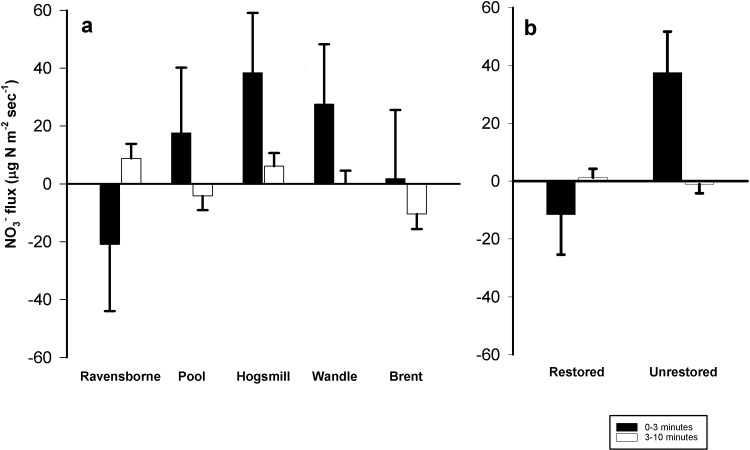
Average NO3- fluxes (μg N m-2 sec-1) among a) the study rivers (restored and unrestored combined) and between (b) the combined restored and unrestored reaches from all London rivers. Columns represent average values (N = 12–20) + one standard error. Both physical disturbance (T = 0–3 minutes) and biogeochemical activity (T = 3–10 minutes) are presented in each panel. There was no significant difference in NO3- fluxes between rivers. However, there was a significant regeneration of NO3- from sediment in unrestored sites over the 0–3 minutes period, but not difference between fluxes at 3–10 minutes. Positive flux values represent uptake/removal of nutrients from the water column and negative flux values represent release of nutrients from the sediment (regeneration).